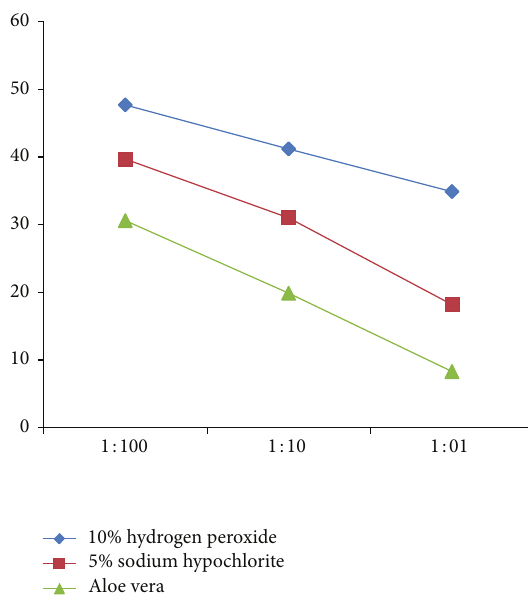
Figure 2: Comparison of three disinfectants at various concentra- tions (CFU/mL).